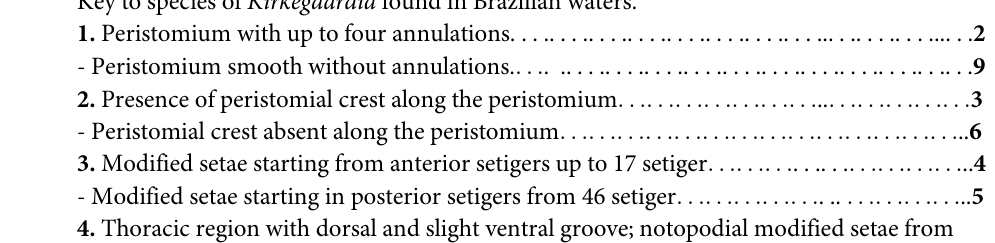
per segment. Abdominal notosetae slightly longer than abdominal neurosetae. Denticulated